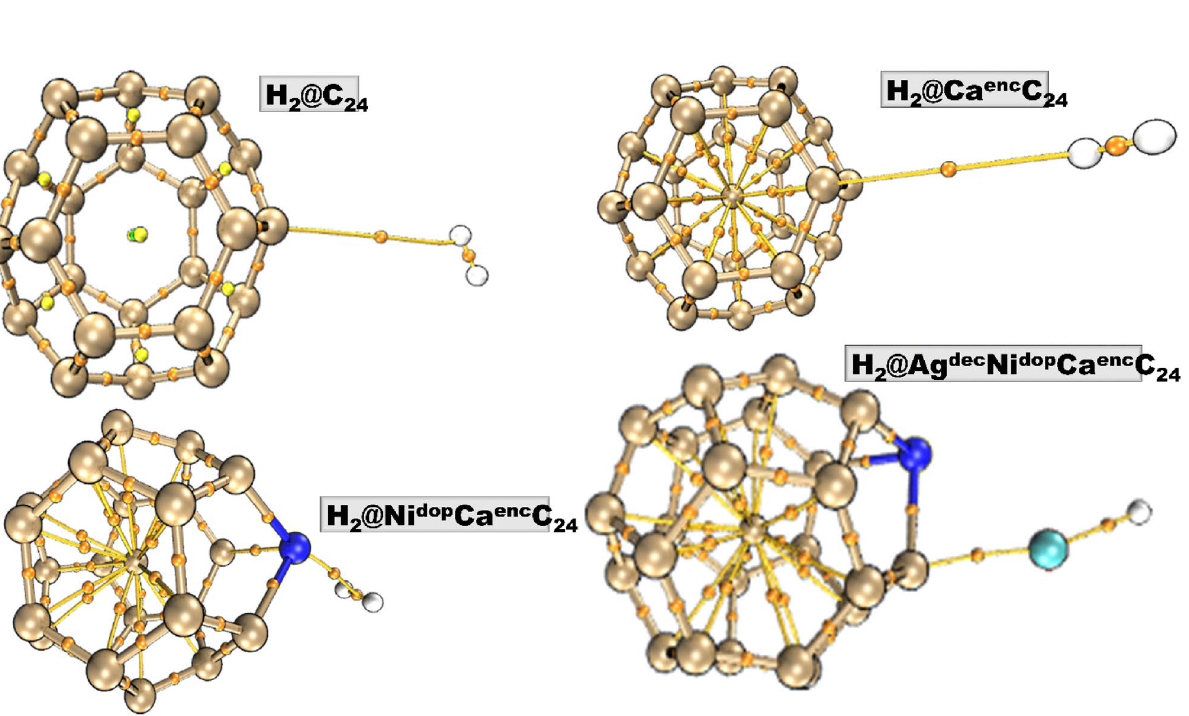
Figure 5. QTAIM molecular graph plot of the studied hydrogen-adsorbed